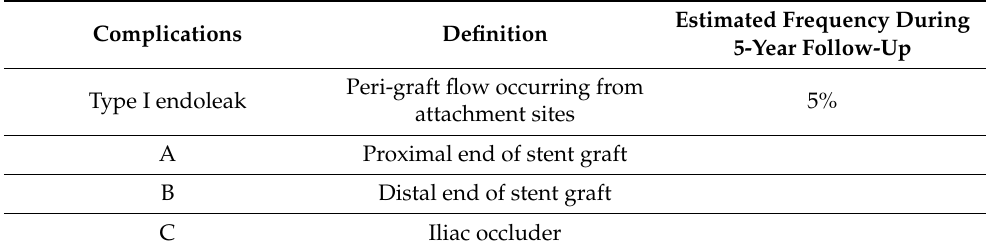
Table 1. Long-term graft-related complications after EVAR – Adapted from open access ref. [4]. 2018, Elsevier B.V. on behalf of European Society for Vascular